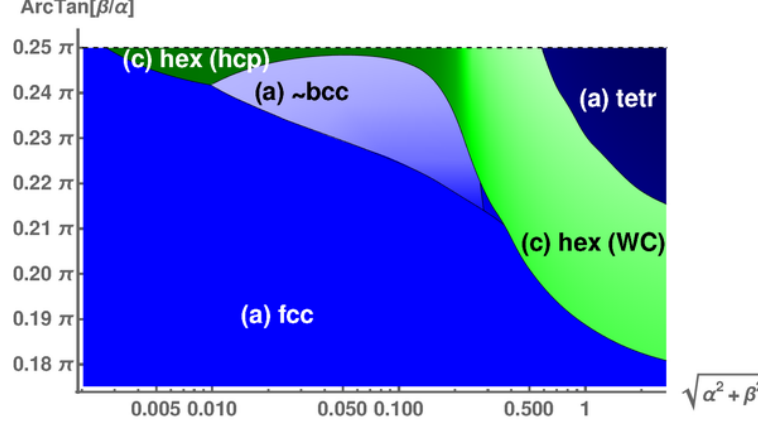
Figure 11: The details of the phase diagram near α = β . We use angular coordinates and show the horizontal axis in logarithmic scale. Notation as in fig.